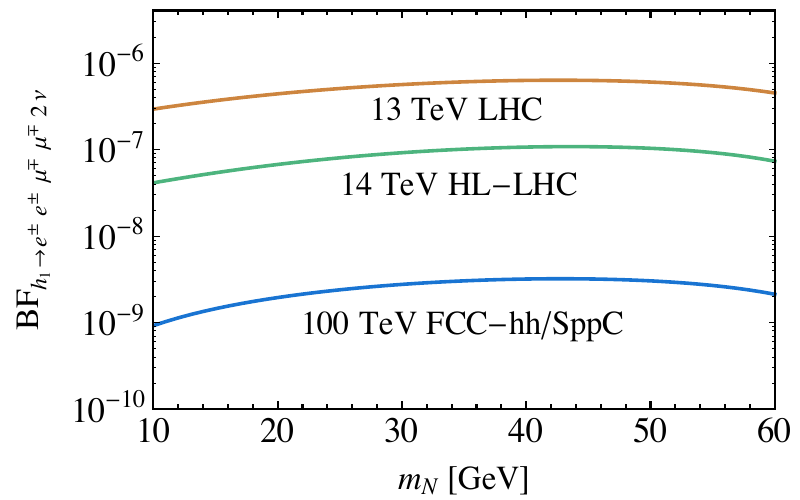
Figure 3 . 95% C.L. limits on the combined branching fraction BF BF sig : at the 13-TeV LHC, 14-TeV HL-LHC and 100-TeV FCC-hh/SppC with 280 fb (cid:0) 1 , 3 ab (cid:0) 1 , 20 ab (cid:0) 1 luminosities, respectively. For these limits, h 2 is assumed to be heavy and only h 1 decay contributes to the NN